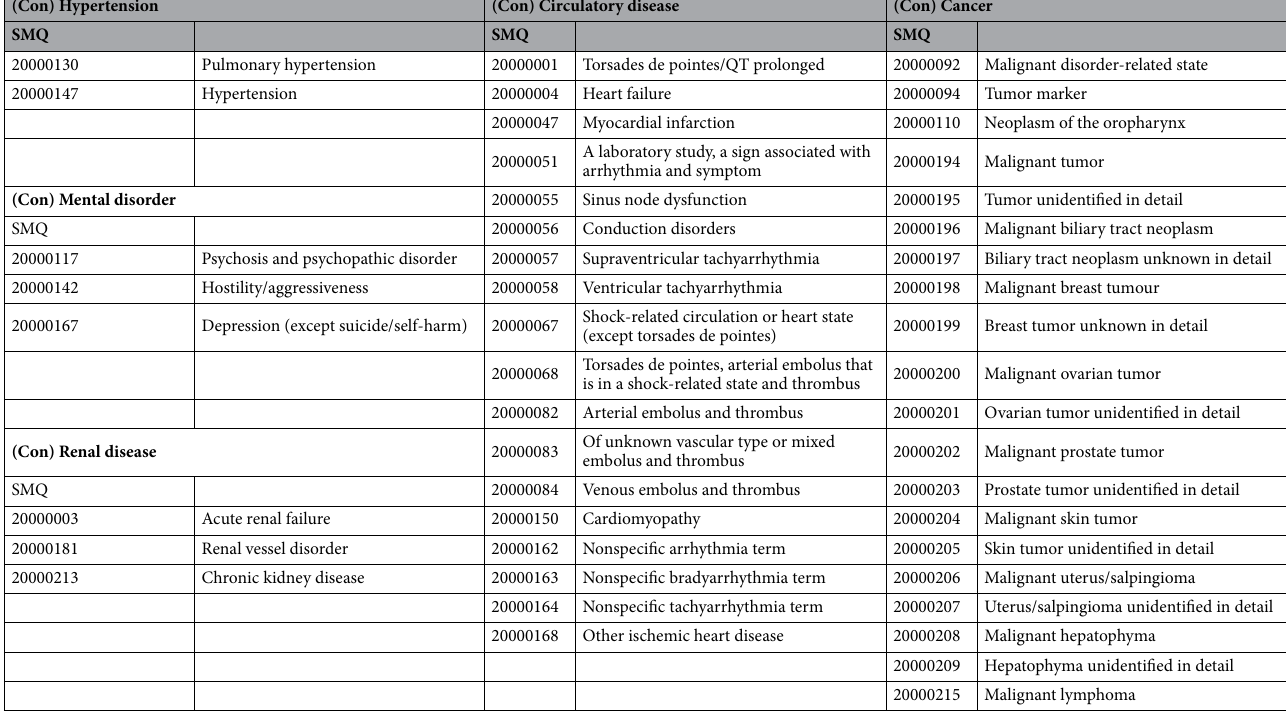
Table 7. Definition of cancer history. Concomitant disease examined hypertension, cardiovascular disease, cancer, mental disorder, and renal failure. Each of these combined multiple SMQs and defined them as one concomitant disease. One group was used for hypertension, three groups for mental disorder, three groups for renal failure, 15 groups for cardiovascular disease, and 20 groups for cancer. (Con): concomitant